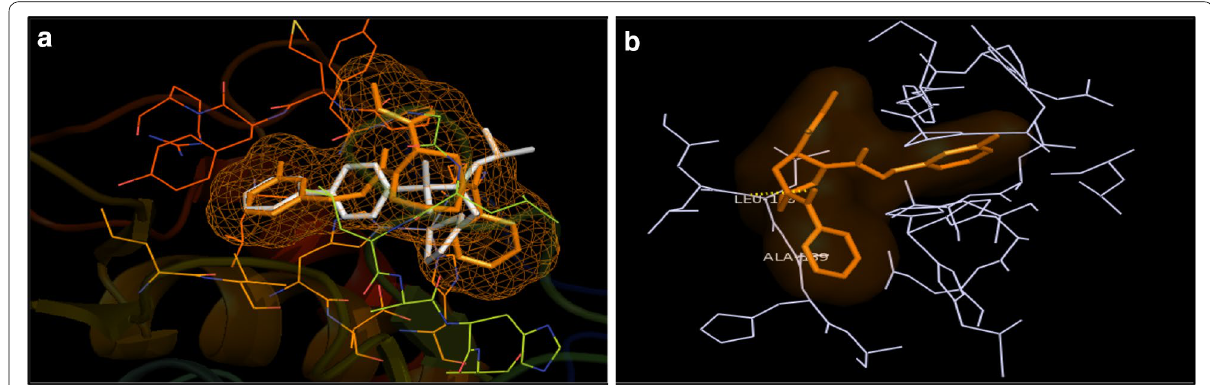
Fig. 8 a Overlay of the docked pose of compound 7 (orange) with that of PDB Ligand 4H3X (white); b docked pose: H-bond interaction of com- pound 7 in the binding site of MMP-9 protein